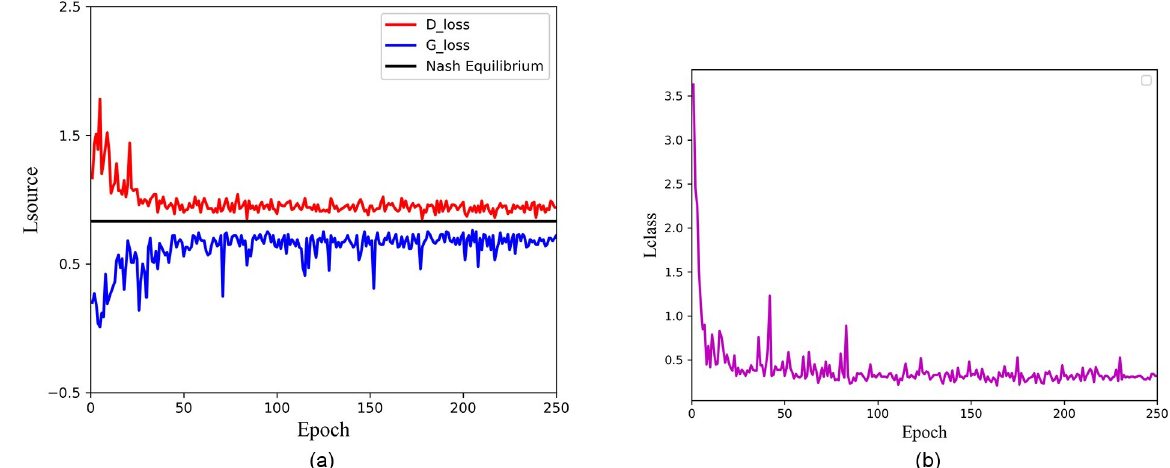
Fig 16. ACGAN-SDAE training loss. (a) adversarial loss, (b) classification loss.